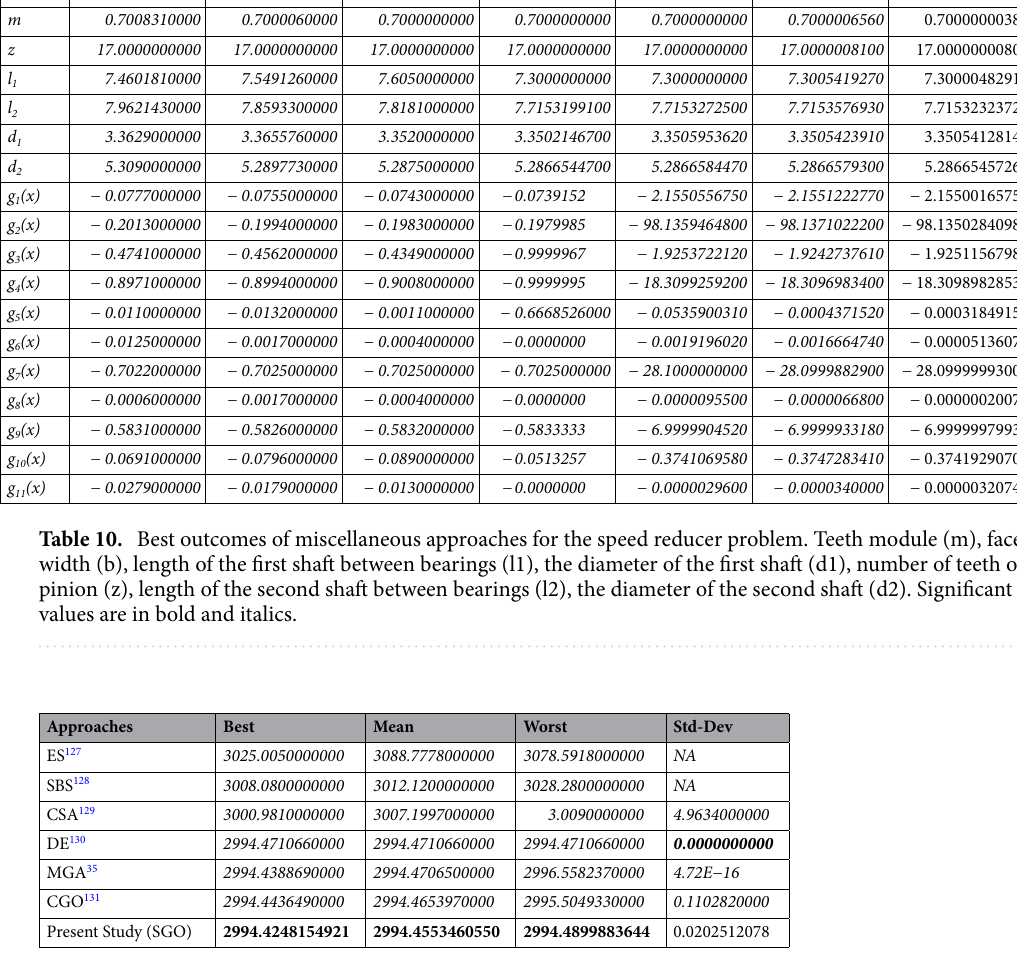
Table 11. Statistical results for the speed reducer problem considering different approaches. Significant values are in bold and italics.